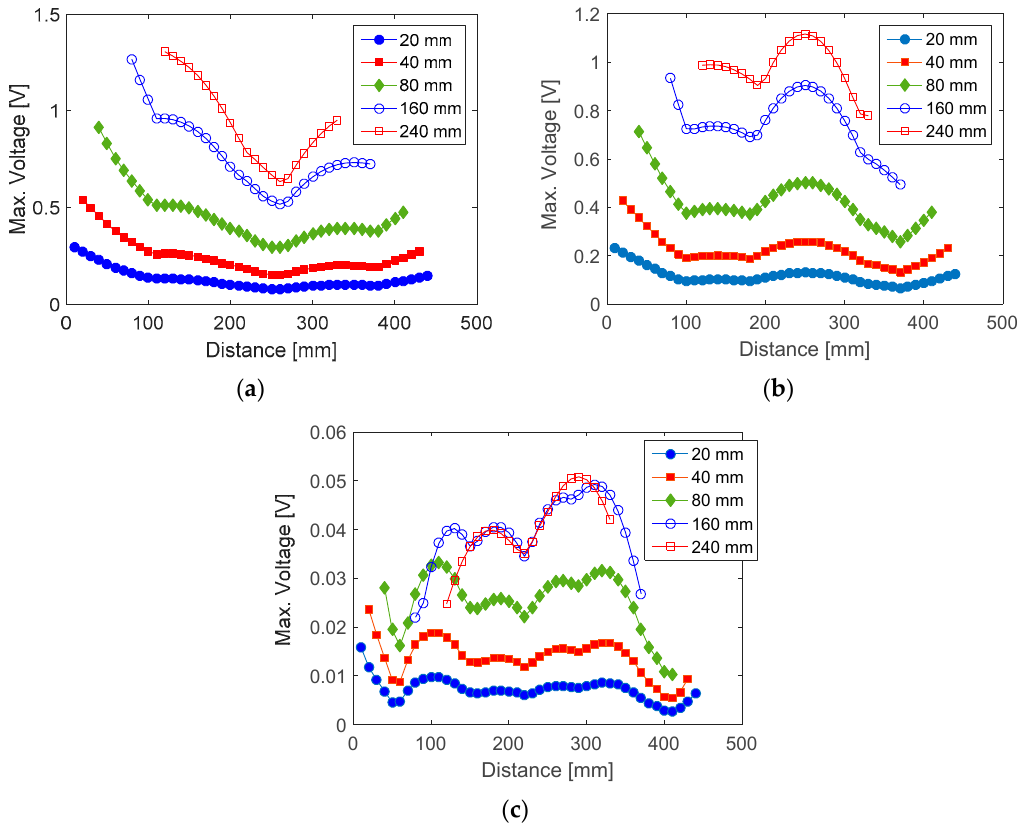
Figure 9. Simulated output voltage of PVDF sensor with different sensor lengths and positions. ( a ) Impact at location 1; ( b ) Impact at location 2; ( c ) Impact at location 3.